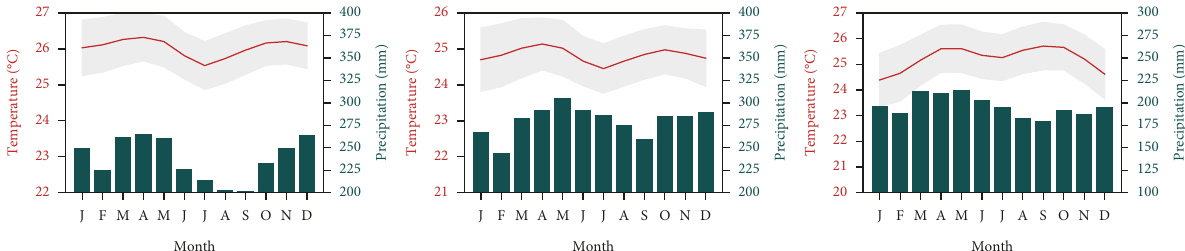
Figure 14: Climographs of KG class Aw and the two KM12 clusters that share the corresponding area (left: Aw tropical rainforest KG climate; center: KM12 cluster 11; right: KM12 cluster 12). Temperature variations are similar in all three, whereas precipitation is different in the two k -means clusters.